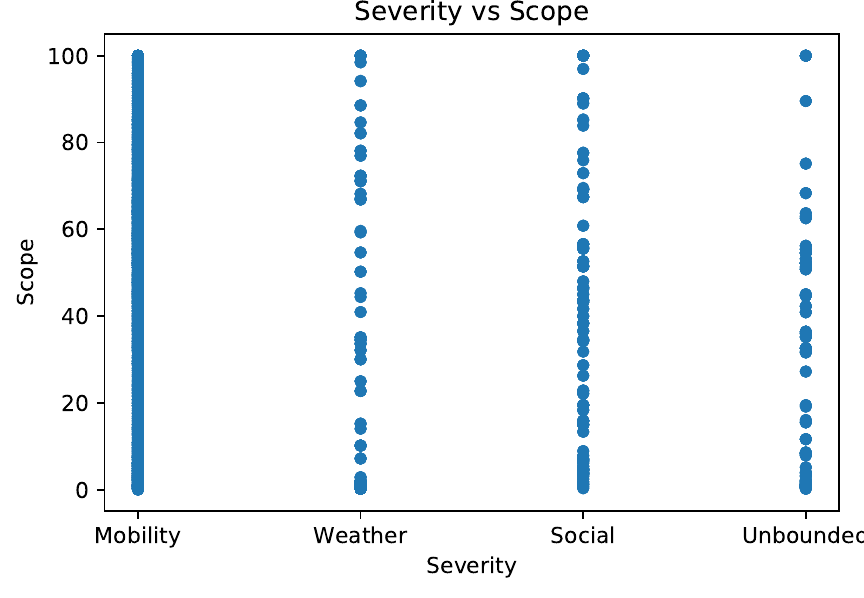
Figure 8. Scope in function of